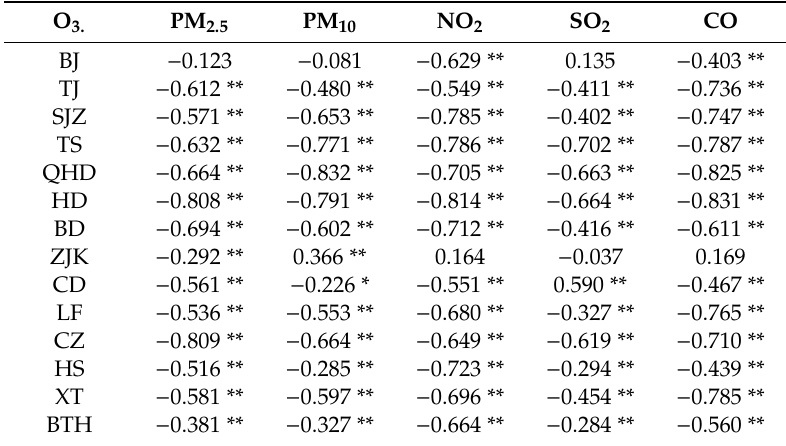
Table 3. Spearman correlation coefficients between O 3 and other air pollutants.